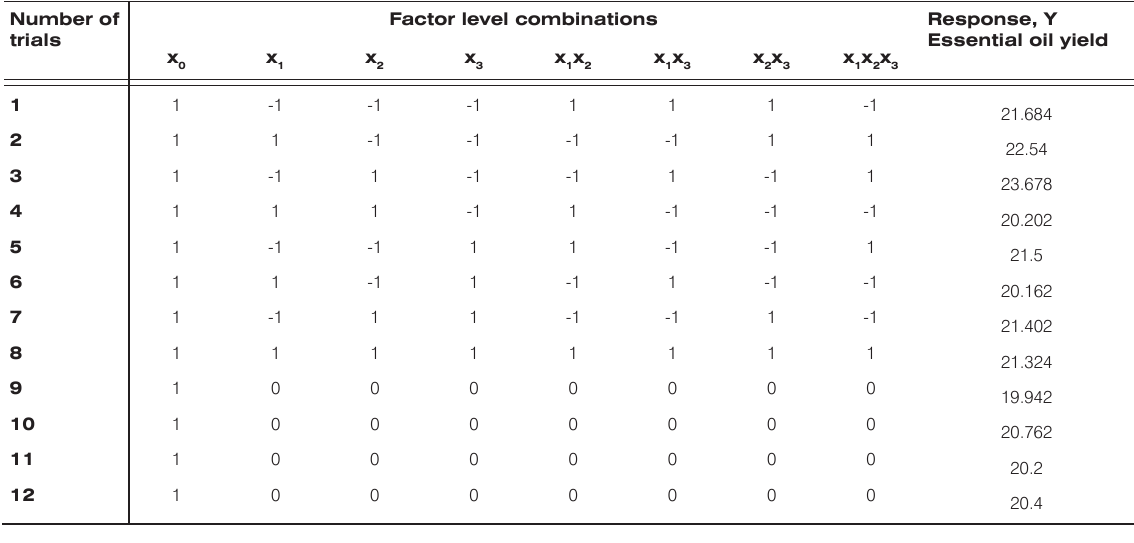
Table 2. Experimental matrix and values obtained for the essential oil yield. Number of trials